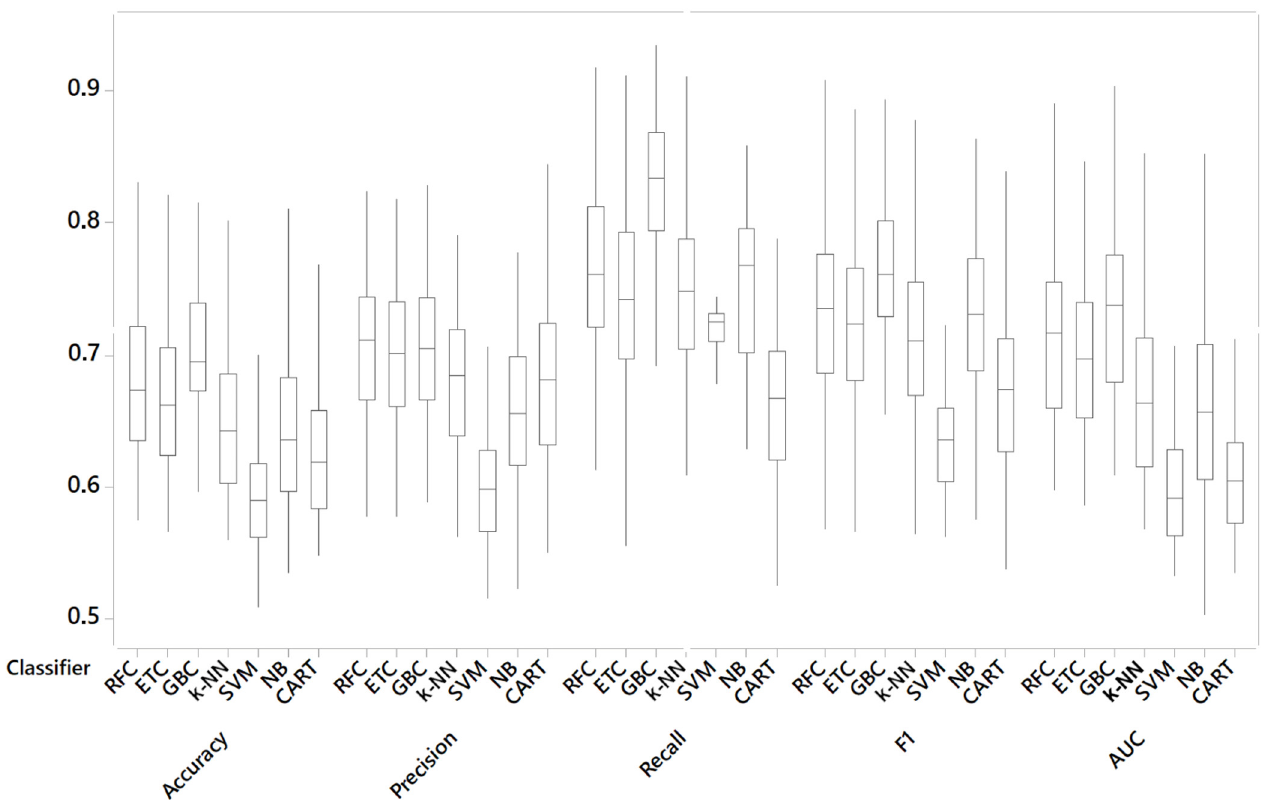
Figure 2. Boxplot of metrics (accuracy, precision, recall, F1, AUC) of ML classifiers for the CA problem.